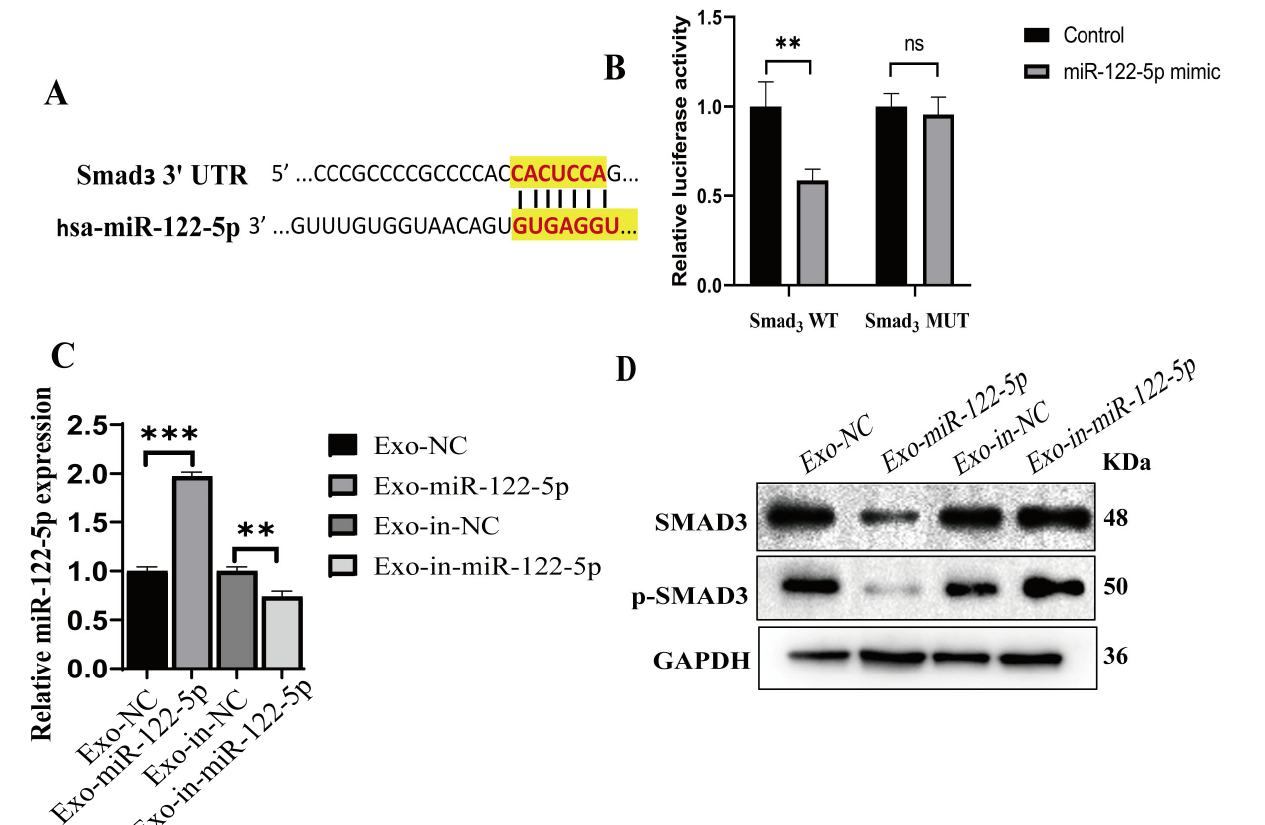
Figure 4. miR ‐ 122 ‐ 5p targets and negatively regulates SMAD3. ( A ) Binding site prediction of miR ‐ Figure 4. miR-122-5p targets and negatively regulates SMAD3. ( A ) Binding site prediction of miR- 122 ‐ 5p in SMAD3 3 ′‐ UTR. ( B ) Luciferase analysis showing miR ‐ 122 ‐ 5p targeting SMAD3. ( C ) The 122-5p in SMAD3 3 (cid:48) -UTR. ( B ) Luciferase analysis showing miR-122-5p targeting SMAD3. ( C ) The expression of miR ‐ 122 ‐ 5p in Exo ‐ miR ‐ 122 ‐ 5p and Exo ‐ in ‐ miR ‐ 122 ‐ 5p. ( D ) Protein expression of expression of miR-122-5p in Exo-miR-122-5p and Exo-in-miR-122-5p. ( D ) Protein expression of SMAD3 and p ‐ SMAD3 in DPCs treated with Exo ‐ miR ‐ 122 ‐ 5p and Exo ‐ in ‐ miR ‐ 122 ‐ 5p. ** p < 0.01, *** SMAD3 and p-SMAD3 in DPCs treated with Exo-miR-122-5p and Exo-in-miR-122-5p. ** p < 0.01, p < 0.001. *** p <